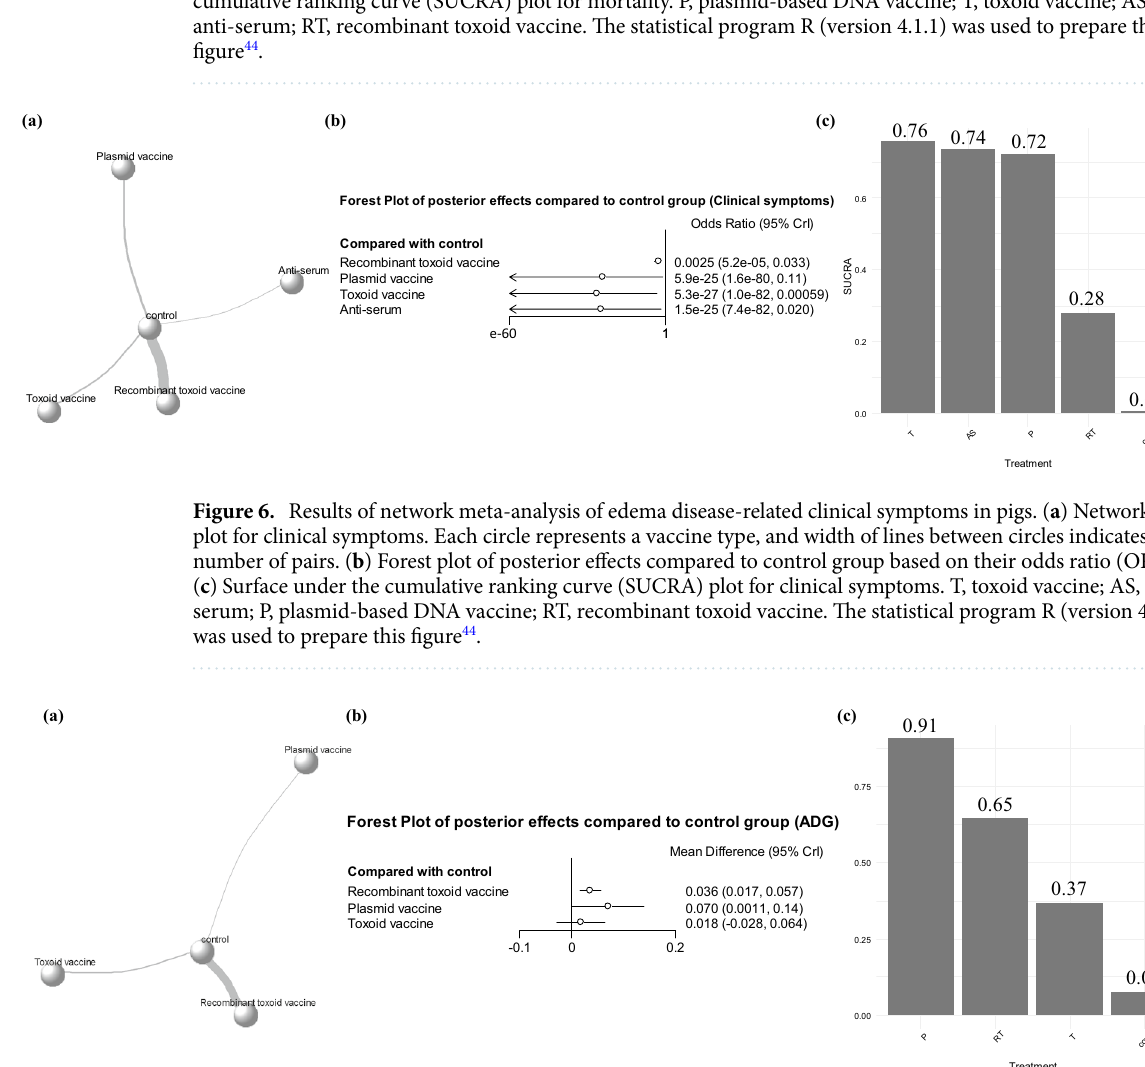
Figure 7. Results of network meta-analysis of average daily weight gain (ADG) in pigs. ( a ) Network plot for ADG. Each circle represents a vaccine type, and width of lines between circles indicates number of pairs. ( b ) Forest plot of posterior effects compared to control group based on their mean difference (MD). ( c ) Surface under the cumulative ranking curve (SUCRA) plot for ADG. P, plasmid-based DNA vaccine; RT, recombinant toxoid vaccine; T, toxoid vaccine. The statistical program R (version 4.1.1) was used to prepare this figure 44